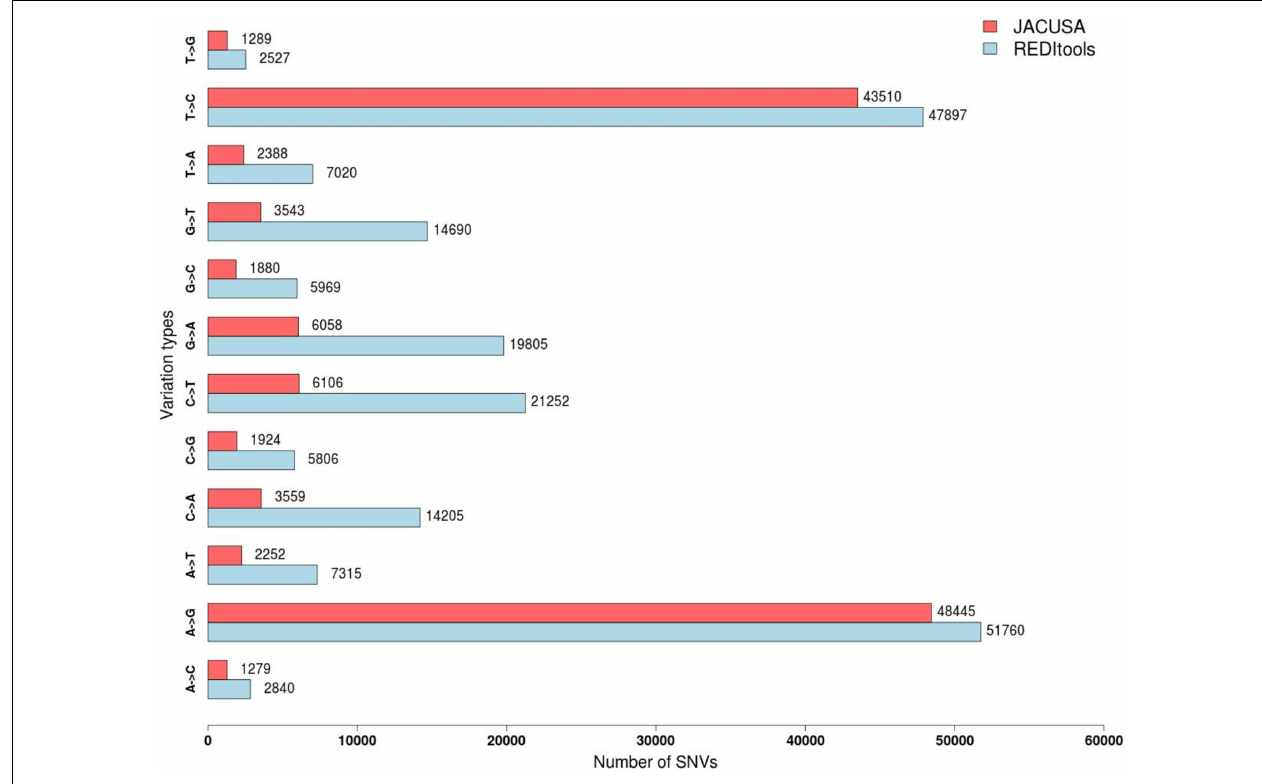
FIGURE 3 | Distribution of single nucleotide variants detected by JACUSA vs REDItools on trimmed reads SRR607967 aligned by STAR on hg19 human genome assembly.